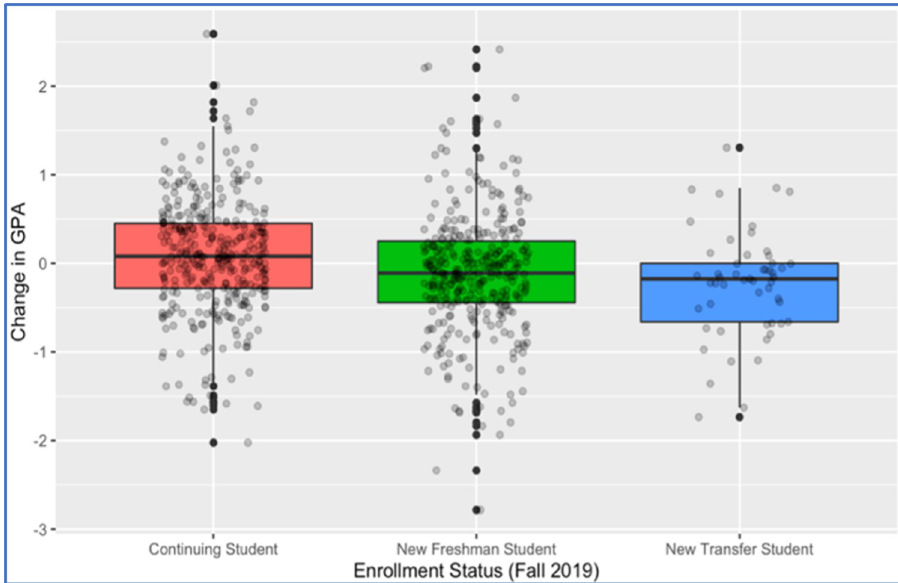
Fig 2. Distribution of GPA change by students’ enrollment status in FA 2019 [full